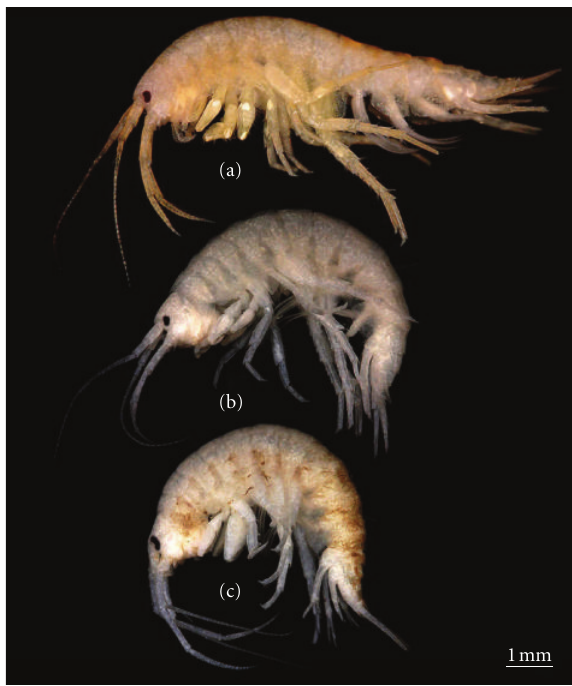
Figure 1: Photographs of males of (a) Gammarus pulex ; (b) Gammarus fossarum ; (c) Echinogammarus berilloni